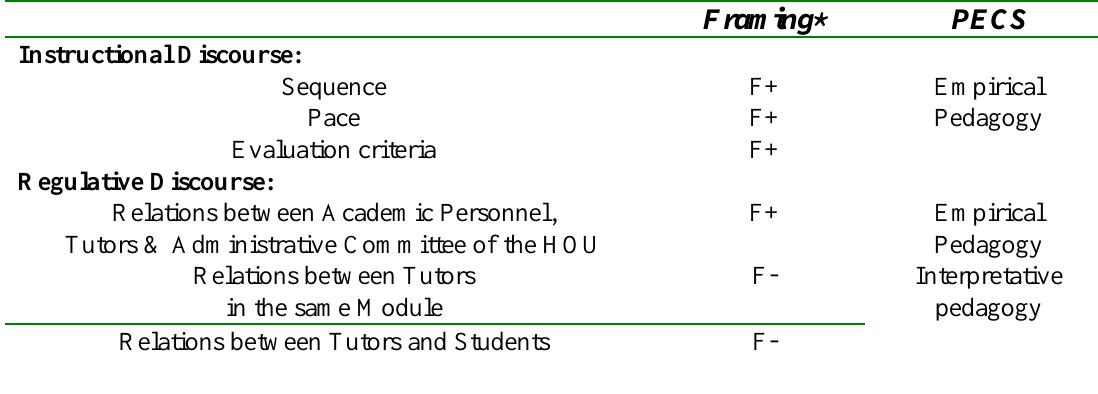
Table 1. Pedagogical Practices: Framming and PECS